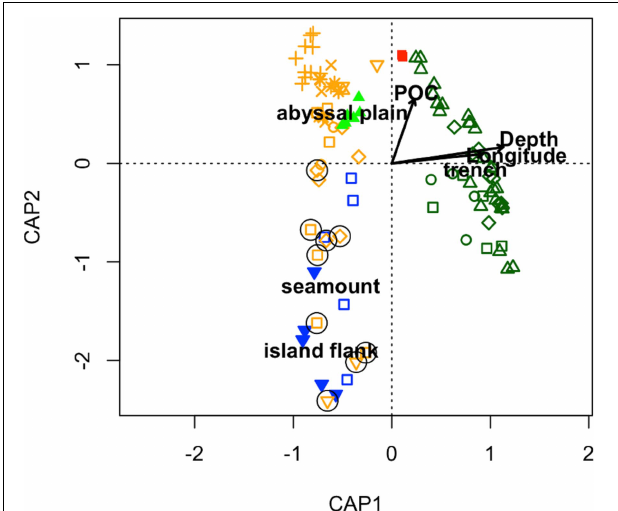
FIGURE 8 | Principal coordinate analysis of the baited camera community composition data (points) across the Pacific evaluated in relation to the environmental drivers particulate organic carbon flux as estimated by Lutz et al. (2007) (lutz_poc), longitude, and depth (arrows with lengths twice biplot scores) and habitat types (centroids). Seamount deployments are circled and symbols are as in Figure 5